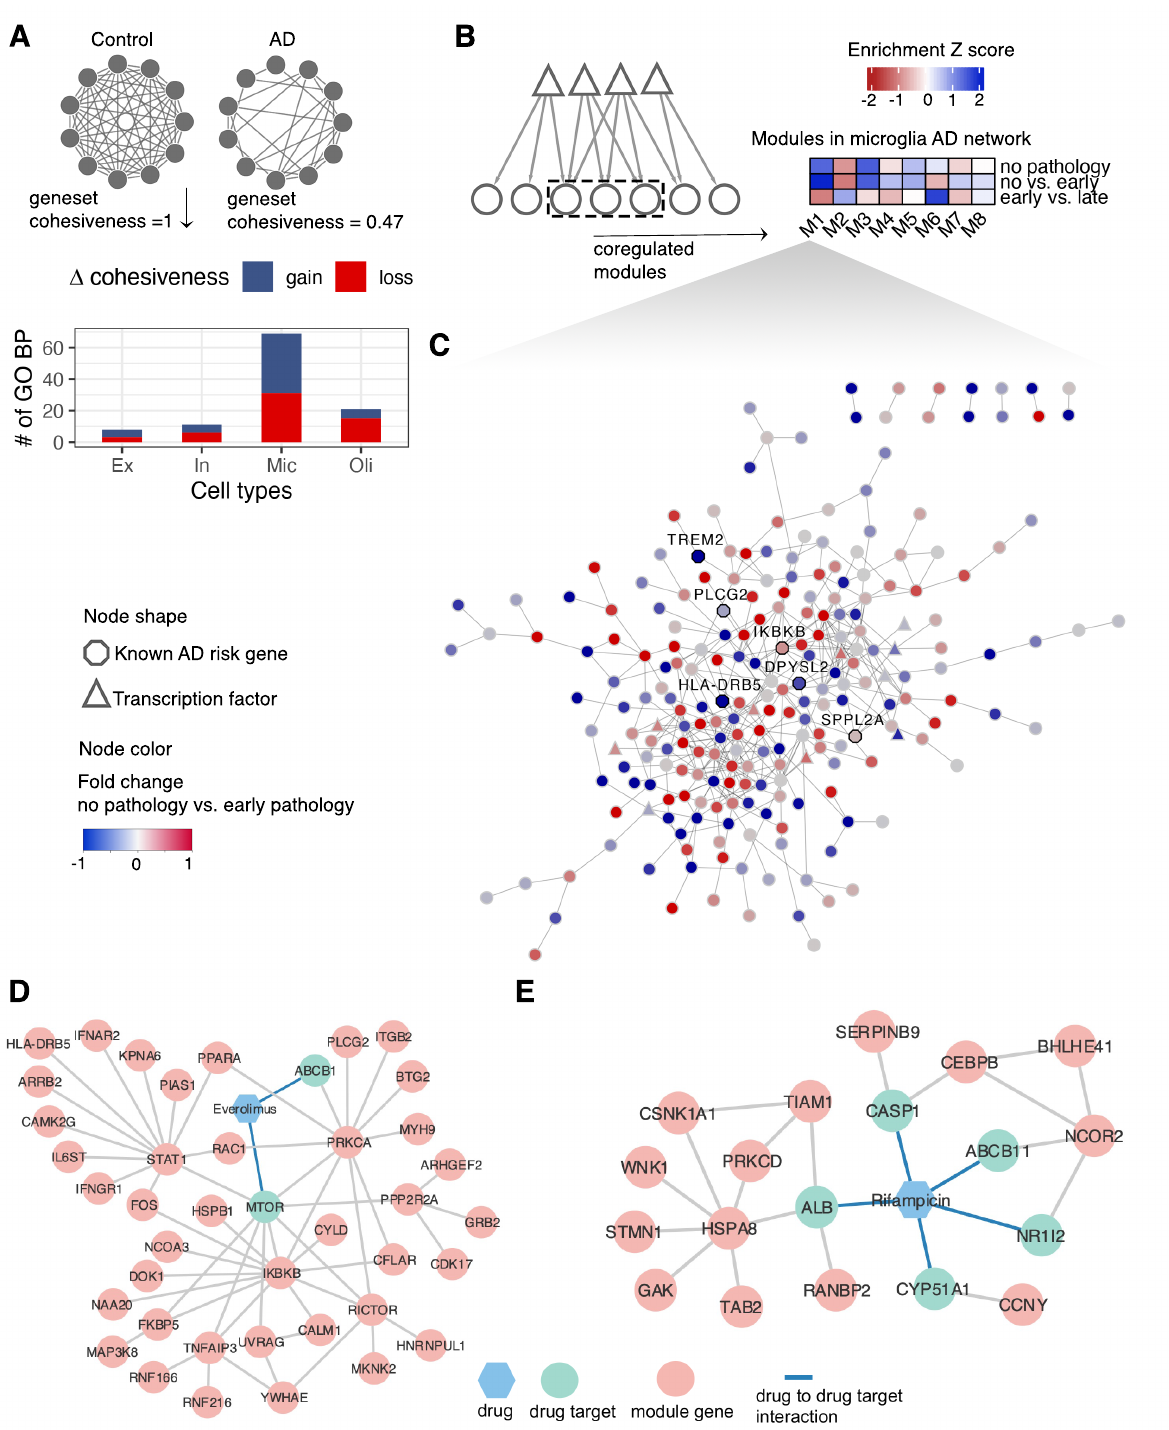
Fig 5. Coregulated gene modules reveal cell type-specific drug-repurposed targets and gene functions in AD. ( A ) Illustration depicting the concept of gene set cohesiveness in a network. The bar plot below shows the number of gene ontology biological process terms (y-axis) that gain (blue) or lose (red) cohesiveness between control and AD networks across all cell types (x-axis; see Methods). ( B ) A heatmap showing the enrichment of co-regulated modules of the microglia AD network within differentially expressed genes in various AD pathologies. The average fold- change of genes within each module was transformed to a Z-score to derive the enrichment score. Negative and positive Z-scores indicate down-